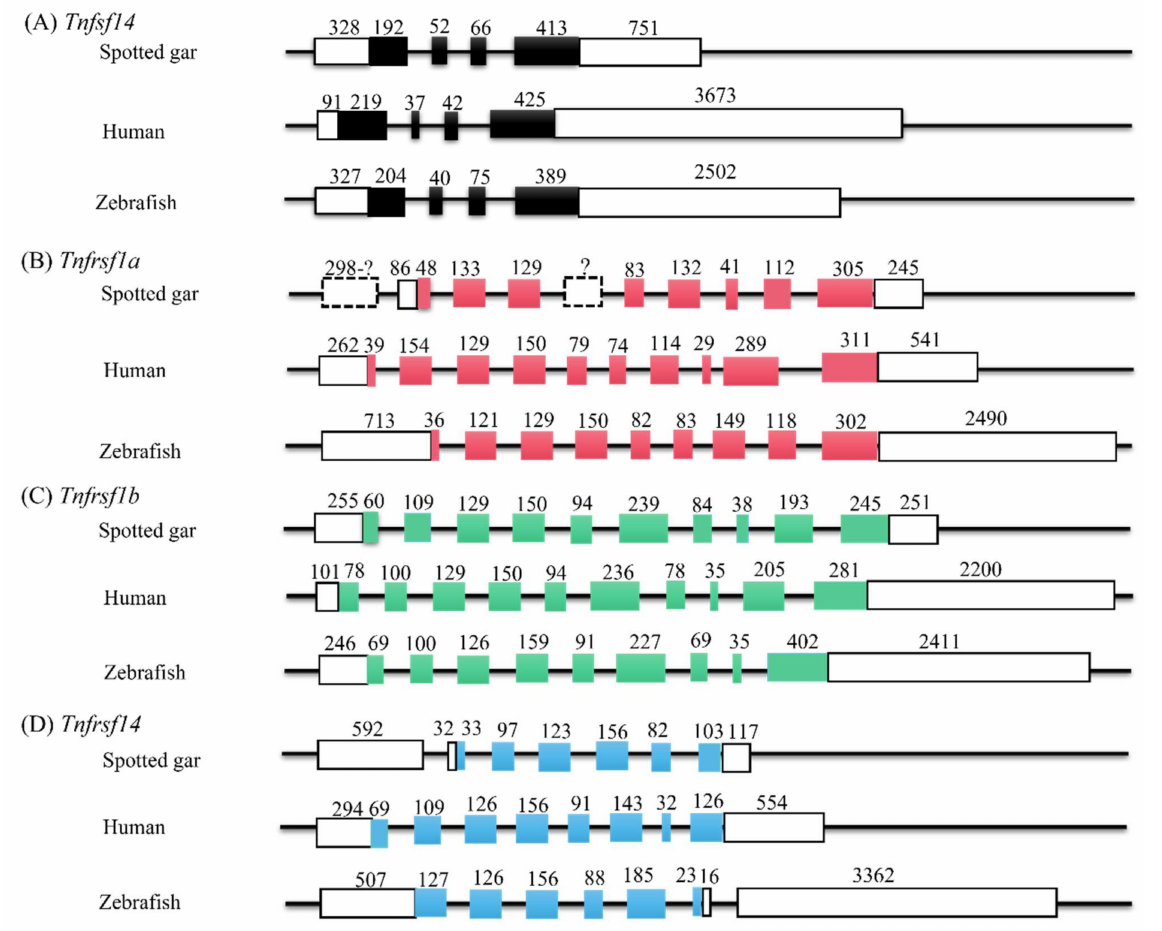
Figure 2. Genomic organization of tnfsf14 ( A ), tnfrsf1a ( B ), tnfrsf1a ( C ) and tnfrsf1a ( D ). The genomic organization was obtained by comparing the cDNA sequences with the genomic sequences retrieved from the NCBI database. Colored boxes represent the coding exons and hollow boxes indicate non-coding exons. The size (bp) of exons is indicated. Note intron size is